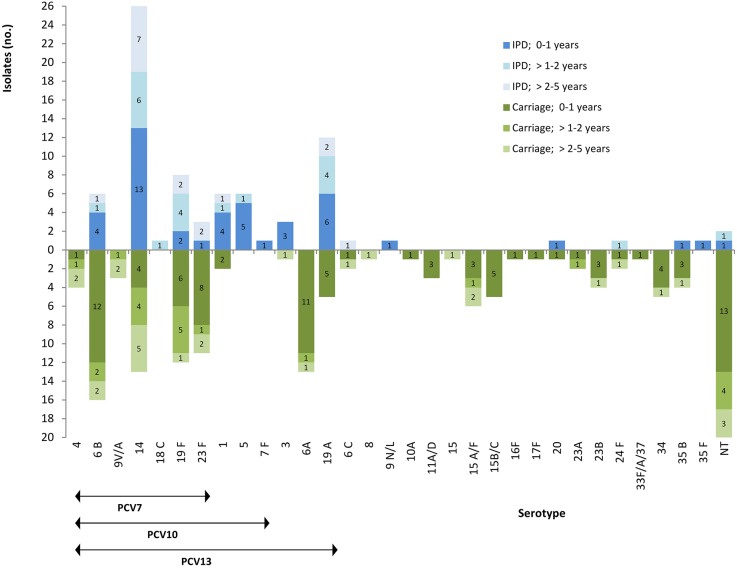
Distribution of serogroup/types and pneumococcal conjugate vaccine (PCV) coverage for invasive pneumococcal disease (IPD) (n = 80) and nasopharyngeal (n = 140) isolates in children aged 5 years and less, shown by age group. NT, non-typeable.